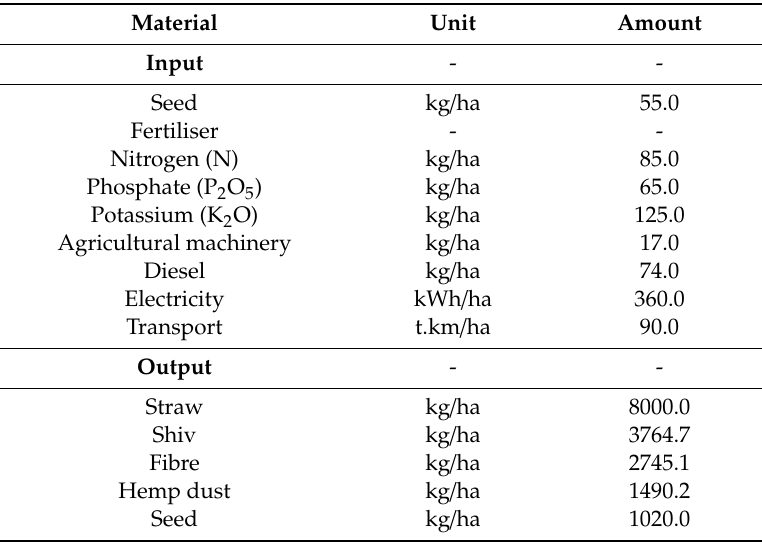
Table 1. Hemp plant and hemp shiv inventory